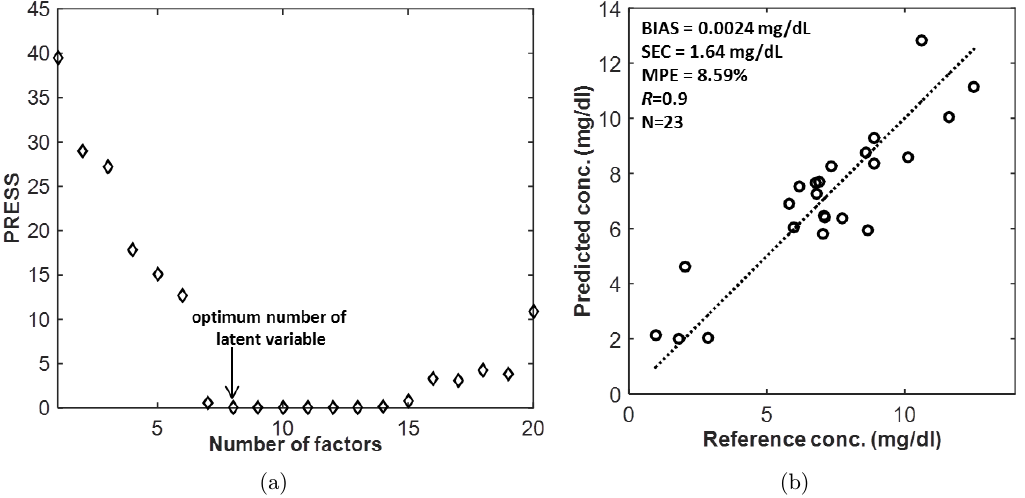
Fig. 3. (a) Plot of the PRESS versus the number of latent variable (LV's, PLS factors) used to build the PLS calibration model. Eight factors were determined to be optimal based upon the lower PRESS indicated by the arrow, (b) Plot of the cross-validated PLS-predicted Cr concentrations predicted by the PLS model using eight LV's versus actual (reference) Cr concentrations from N ¼ 23 patients. Cross-validation was performed by sequentially omitting one spectrum from the calibration model. Statistical parameters are presented in the graph, (c) Scatter plot of Cr concentration determined at the hospital laboratory versus residuals and (d) Bland – Altman scatter plot comparing calculated NIR and laboratory-measured (reference) values for 23 measurement points. Each symbol represents a single human subject. The mean di®erence between the two approaches (blue solid line) and the CI 95 % (red dotted lines) is indicated; Bias ¼ 0 : 0023 (cid:5) 1 : 31 mg/dL, 95%CI = (cid:2) 2.623 mg/dL +2.618